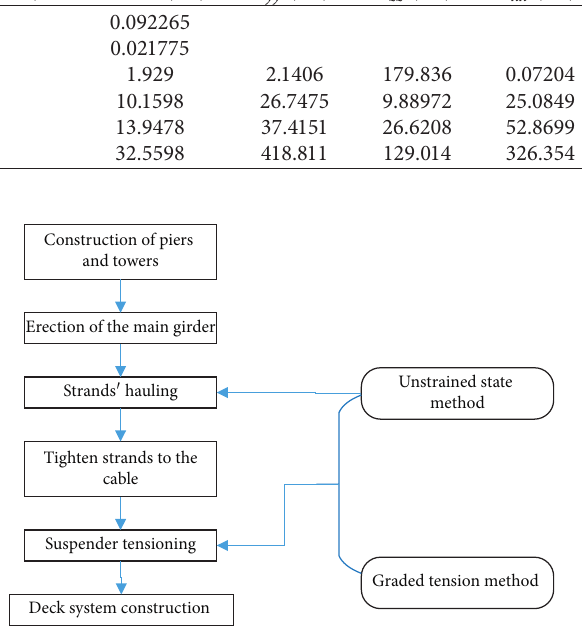
Figure 5: Unstrained state method applied in the construction of self-anchored suspension bridges.